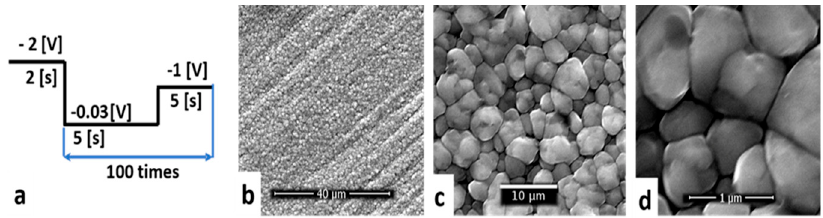
Figure 7. Copper electrodeposition on CNW heat treated: ( a ) schematic representation of applied pulses and ( b – d ) top view SEM images at different magnifications.